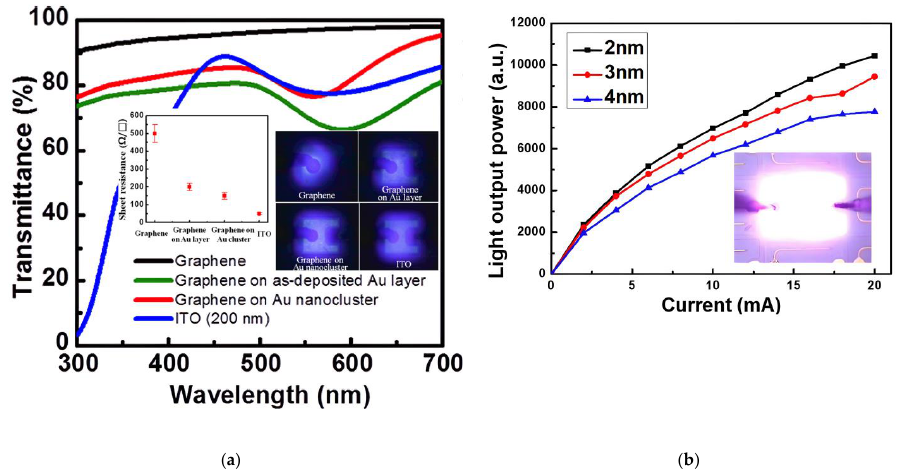
Figure 4. Graphene hybrid TCSL integrated into GaN-based UV MQW LEDs: ( a ) transmission of the graphene networked with Au layer or Au nanocluster compared with ITO and bare graphene. The left and right inset represent the corresponding sheet resistance and EL images of the with four different TCSLs; ( b ) LOP–current characteristics of a graphene/Ag nanoparticle hybrid as TCSL. The Ag nanoparticles (NPs) were formed by Ag films with a thickness varied from 2 nm to 4 nm. Inset: corresponding microscope image of an operating LEDs with graphene/Ag NP as TCSL (red circles in ( b )) at 1 mA forward current. ( a ) Reproduced with permission from [12]. Copyright 2013